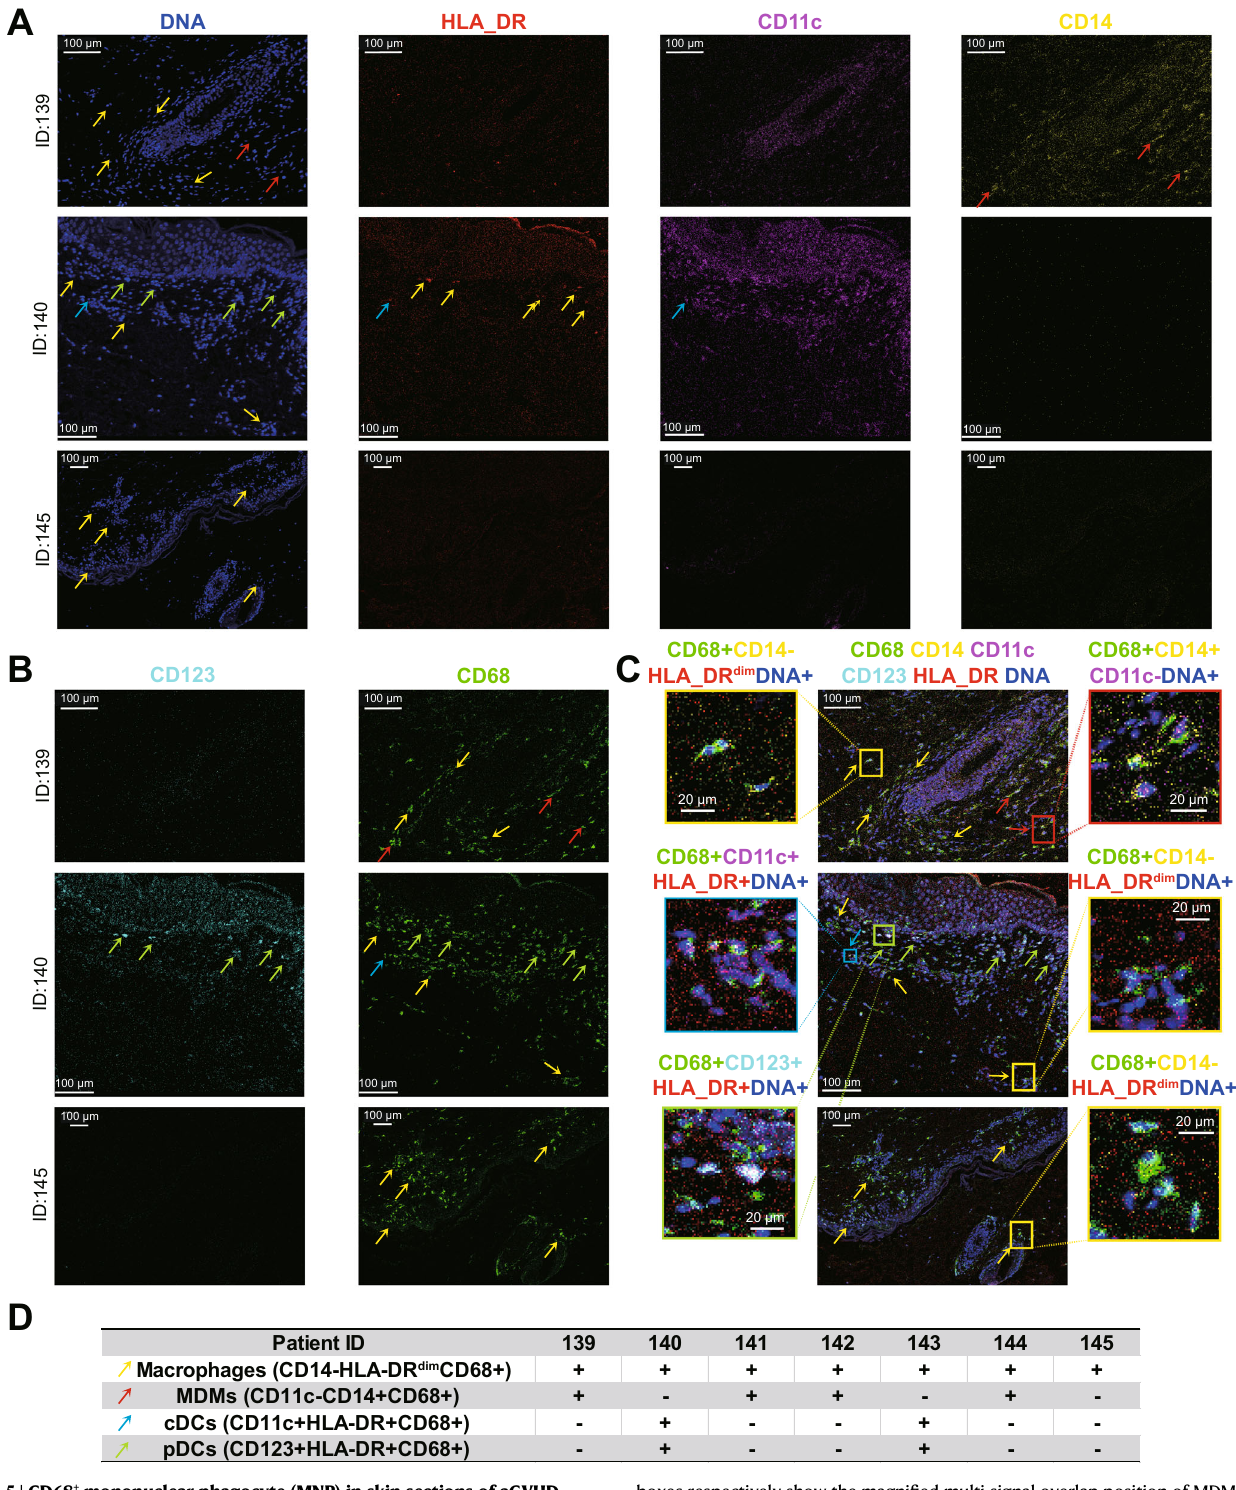
boxes respectively show the magni fi ed multi-signal overlap position of MDMs, macrophages, pDC, and cDC. Scale bar=100 μ m for landscape view and scale bar=20 μ m for magni fi ed view. D Each column is mononuclear phagocyte (MNP) identi fi cation in skin sections from each patient. Each row is the comprehensive phenotypingofoneMNP,andthesymbol+/ − indicatestheMNPisexistence/absent in skin sections of each patient. Displayed channels for each row are: macrophage (CD14 − CD11c − CD68 + ); MDM (CD14 + CD11c − CD68 + ); cDC (CD11c + HLA-DR + CD68 + ); pDC (CD123 + HLA-DR + CD68 +